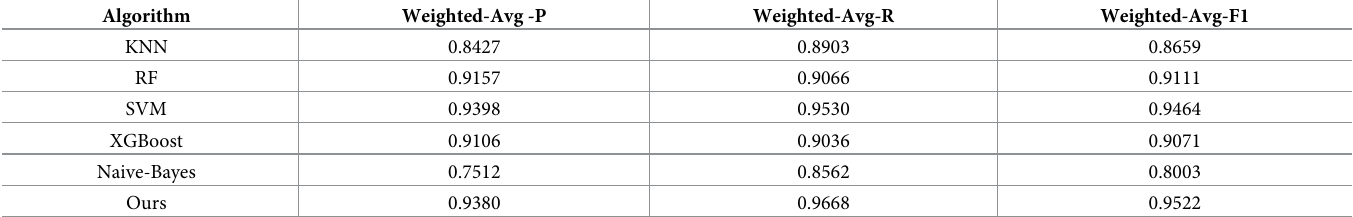
Fig 12. Evaluation of classification model. https://doi.org/10.1371/journal.pone.0284632.g012 Table 2. Compared with traditional machine learning.